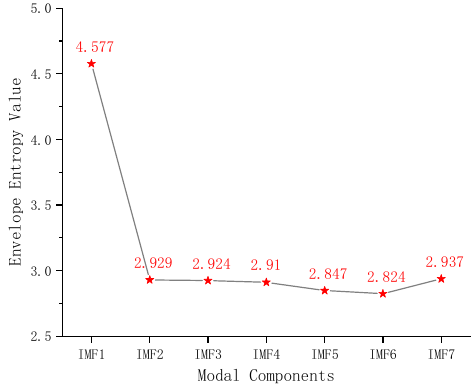
Figure 3. Envelope entropy curve of each modal component.